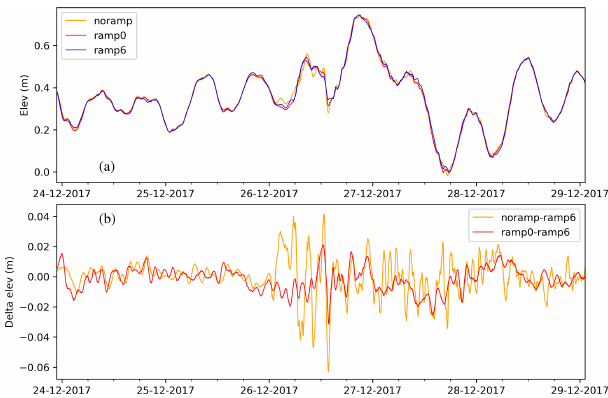
Figure 12. NS1C elevation at Hanstholm station during Decem- ber 2017 forced by ECMWF-IFS data. (a) Results for models forced by the “noramp”, “ramp0”, and “ramp6” methods, and (b) differ- ences between short ramps and the recommended ramp6.